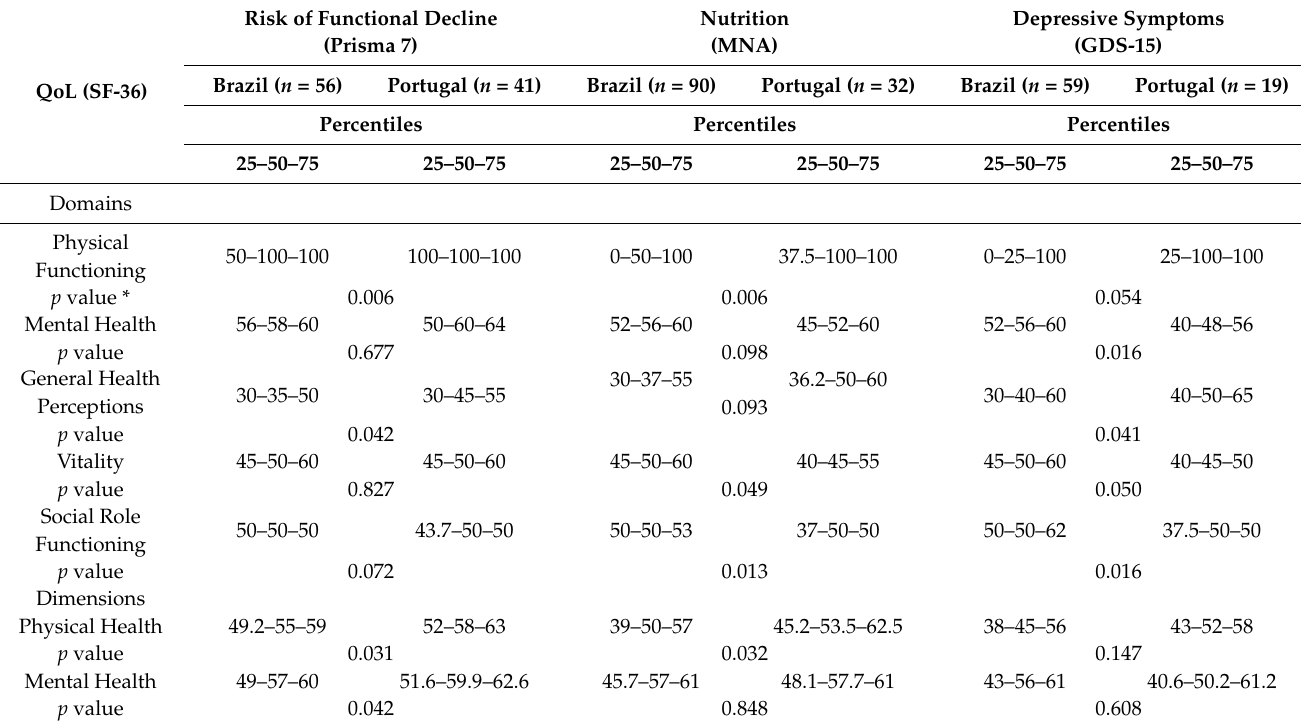
Table 4. Association between QoL and impairment for the variables